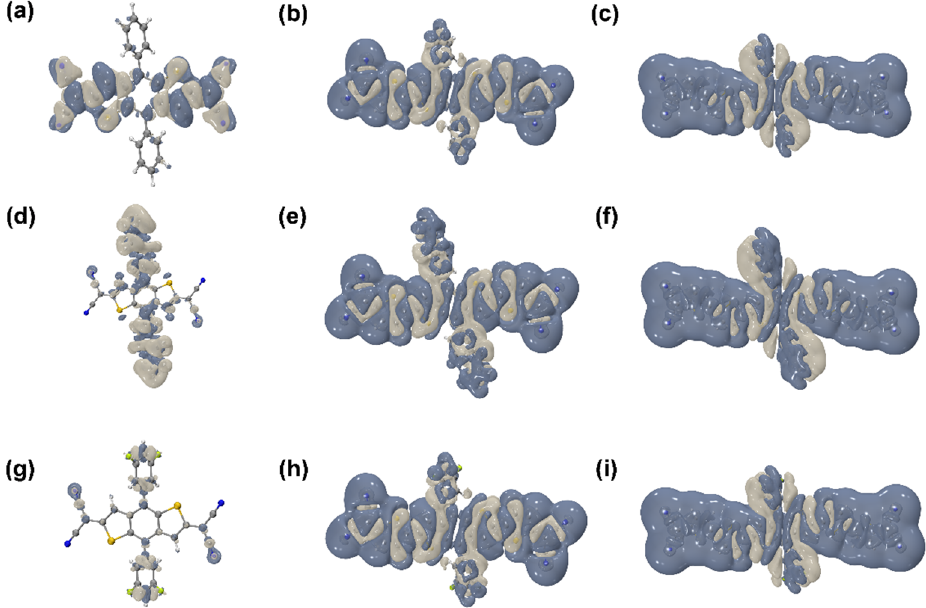
(3) Xp ( ) r − (isovalue = 1100) of the nine compounds (1–9). xxx